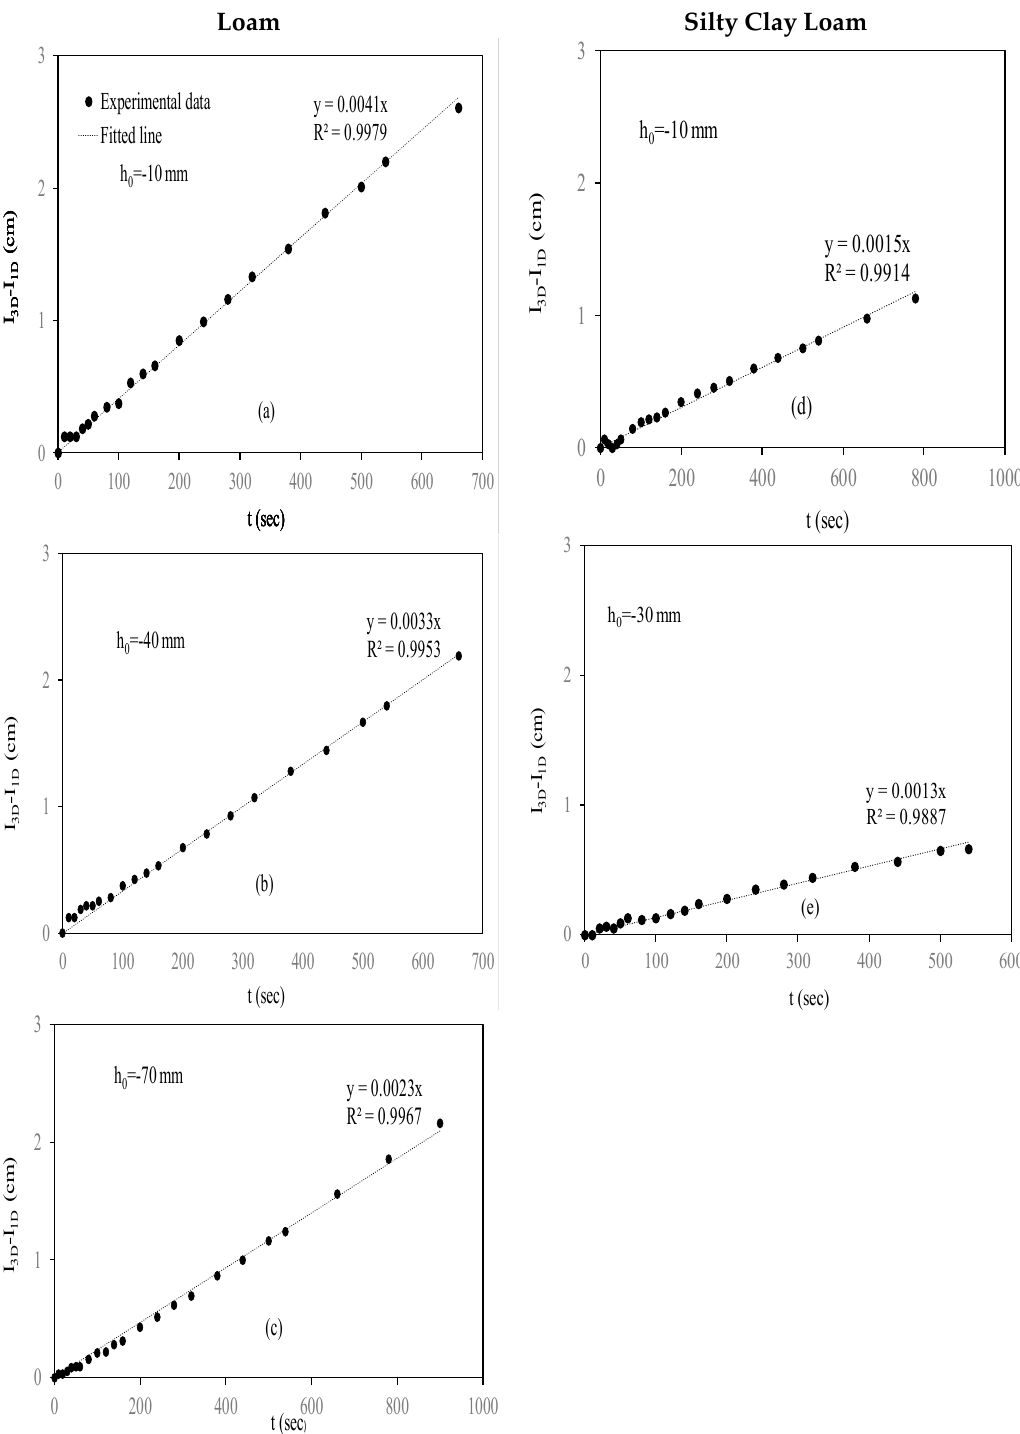
Figure 3. The difference between three- and one-dimensional infiltration flow over time, for pressure heads: ( a ) h 0 = − 10 mm; ( b ) h 0 = − 40 mm; ( c ) h 0 = − 70 mm for Loam soil, and ( d ) h 0 = − 10 mm; ( e ) h 0 = − 30 mm for Silty Clay Loam soil. The fitted line is from Equation